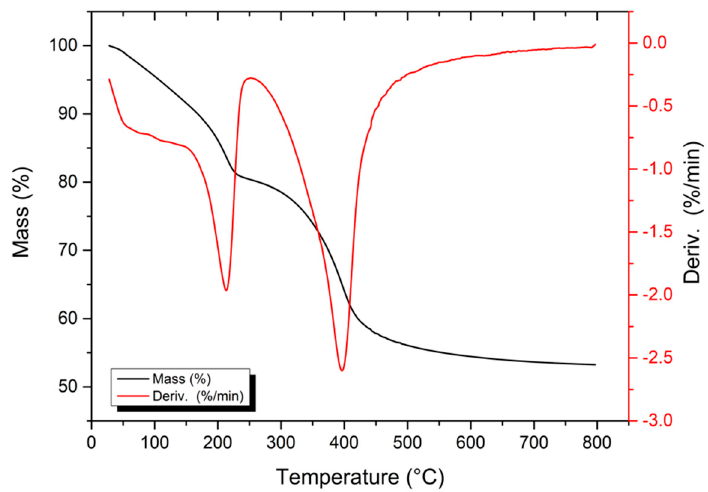
Figure 2. Thermogravimetric and TG/DTG curves of the ZAHD composite .